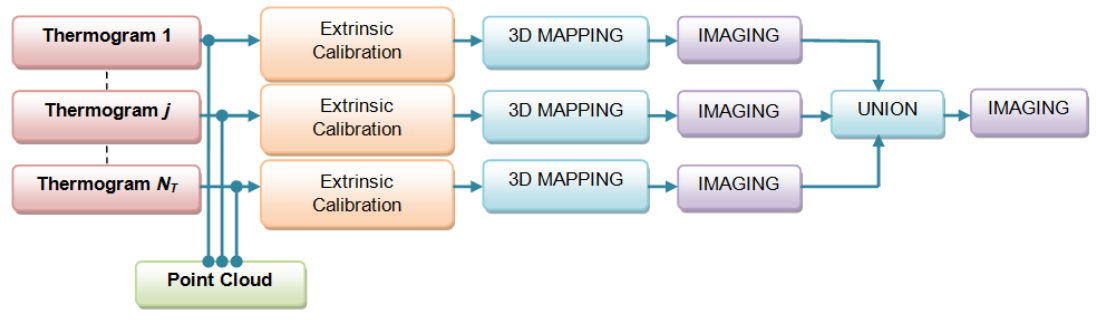
Figure 7. Workflow of the integration of multiple thermograms on the same points cloud. N T is the total number of thermograms integrated.